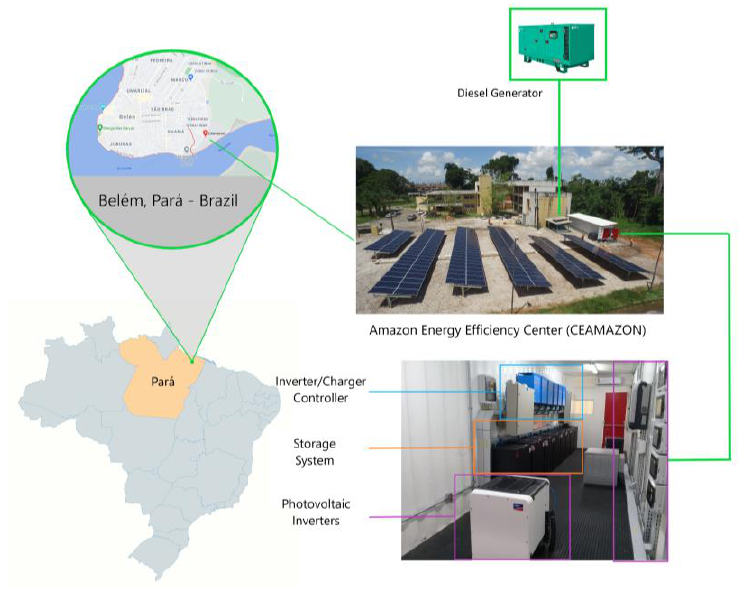
Figure 3. Installed hybrid system at the Federal University of Pará, in Belém, Pará, Brazil. The hybrid system components and their respective descriptions are detailed below and presented in Figure 4.